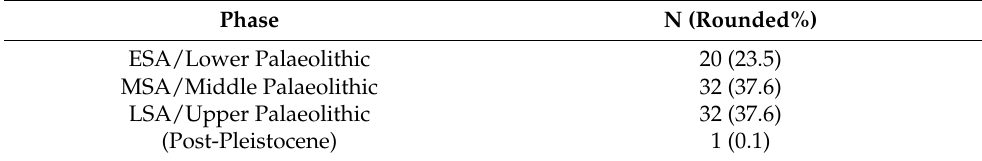
Table 2. The percentages of Table 1 sites that can be tentatively assigned to lithic phases ( n = 85). Phase